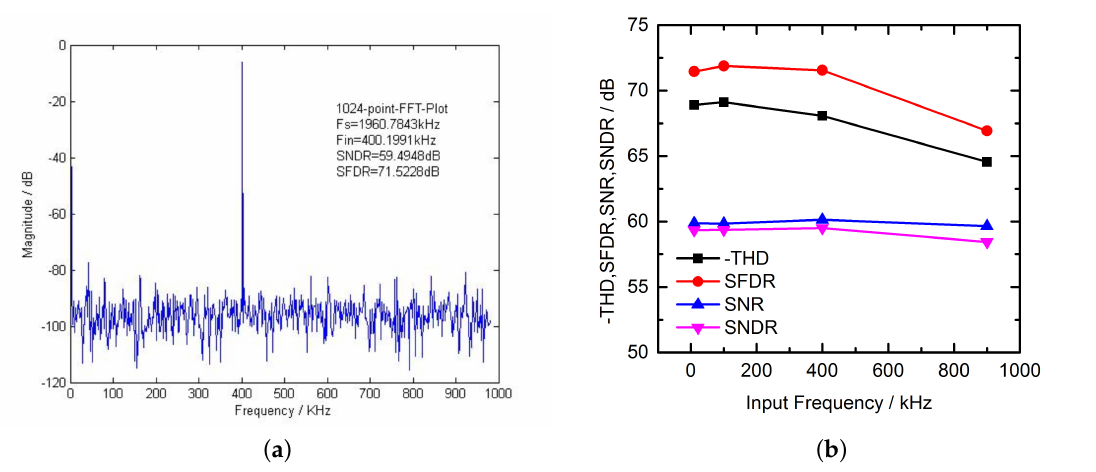
Figure 11. Simulation results of the SAR ADC ( a ) 1024-point FFT spectrum at 1.96 MS/s of SAR ADC; and ( b ) dynamic performance of SAR ADC versus input